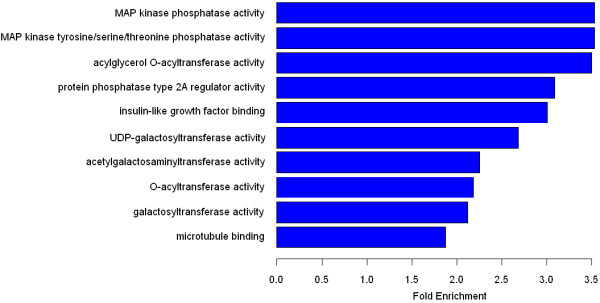
The bar plot of the GO analysis of Molecular Function. The bar plot shows the top ten Fold Enrichment value of the significant enrichment terms of designated gene involving Molecular Function